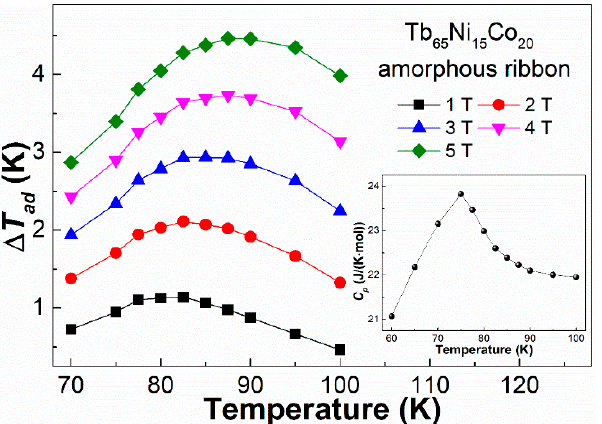
Figure 6. The ∆ T ad - T curves of the Tb 65 Ni 15 Co 20 amorphous ribbon under different magnetic fields, the inset is the C p ( T ) plots.